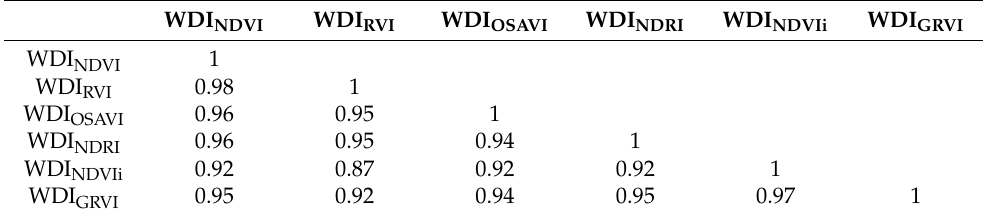
Table 4. Correlations between WDIs calculated from different multispectral indices calculated based on the whole season of 2019.